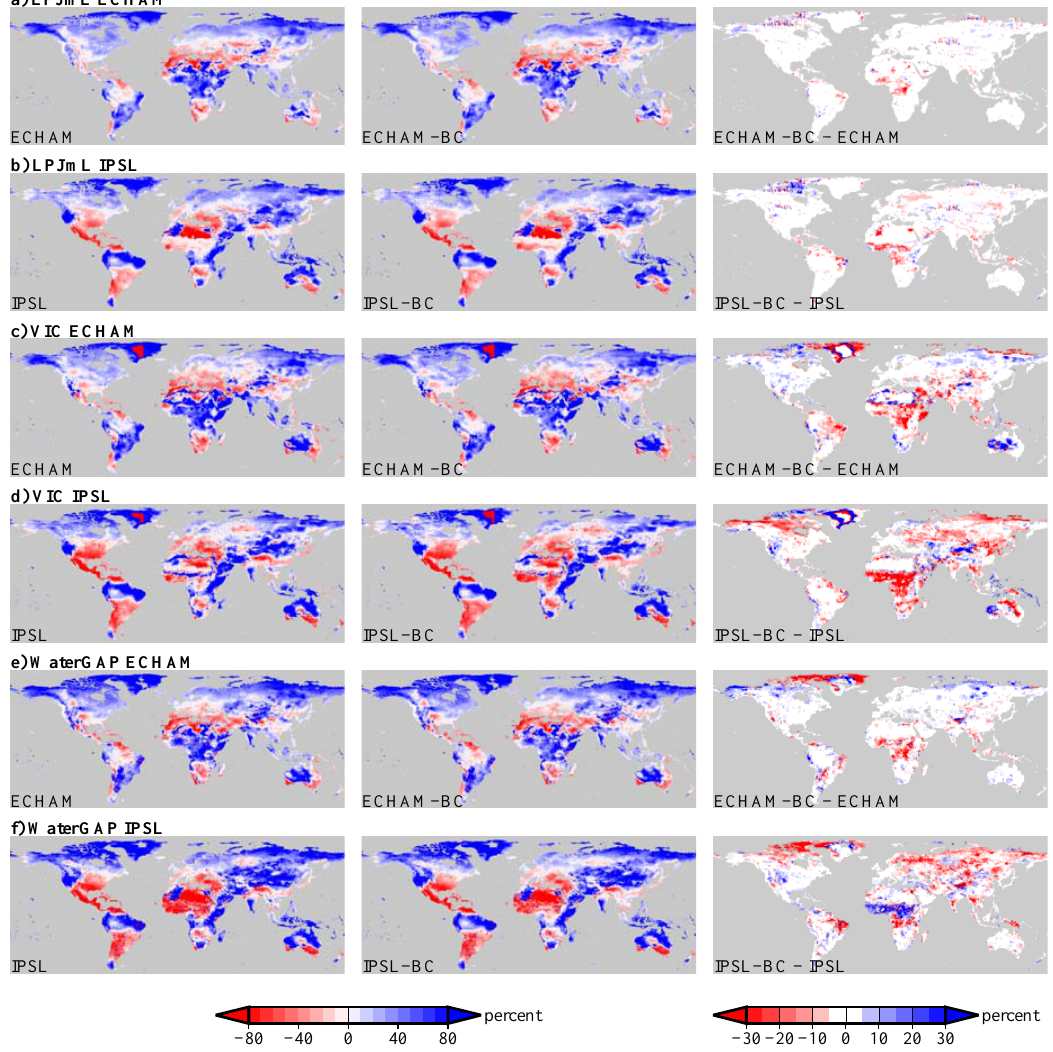
Fig. 8. Mean annual projected changes in simulated runoff; bias corrected results compared to original results. (a, b) LPJmL, (c, d) VIC, and (e, f) WaterGAP. BC denotes simulation results using bias corrected forcings. In the right panels, the areas where the differences in the relative runoff changes are both (1) significant at the 5 percent level and (2) more than 5 percentage points are shown.